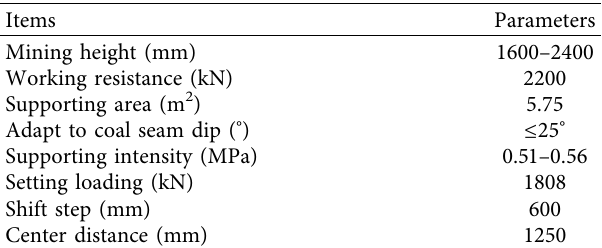
Figure 1: Map and satellite image showing the location of the studied mine and area. Table 1: Hydraulic support used in 3101 working face.